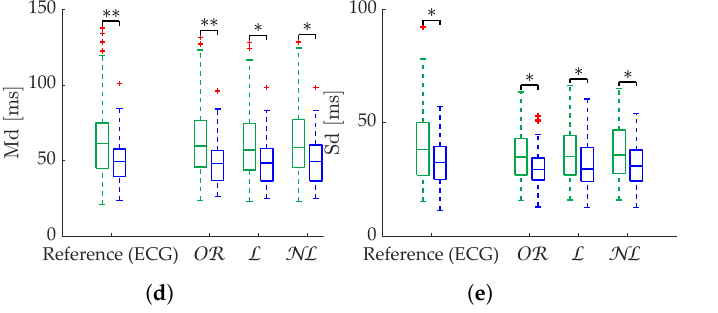
Figure 11. Relax (green)/stress (blue) discrimination of Poincaré metrics from Apple Watch dataset. ( a ) SD1. ( b ) SD2. ( c ) S. ( d ) Md. ( e ) Sd. *: Significant differences ( p < 0.05) between relax and stress groups. **: Significant differences ( p < 0.001) between relax and stress